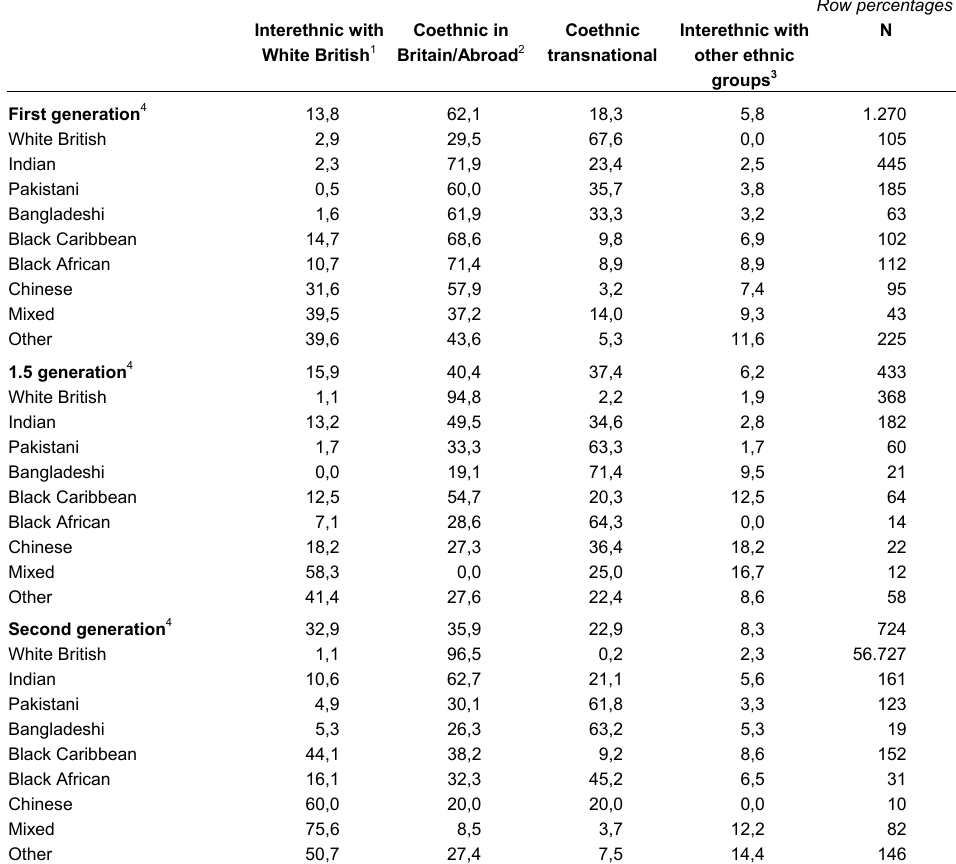
Table 2: Percentage distribution of types of unions by ethnic groups and gene- ration (Female) Row percentages Interethnic with Coethnic in Coethnic Interethnic with N White British 1 Britain/Abroad 2 transnational other ethnic groups 3